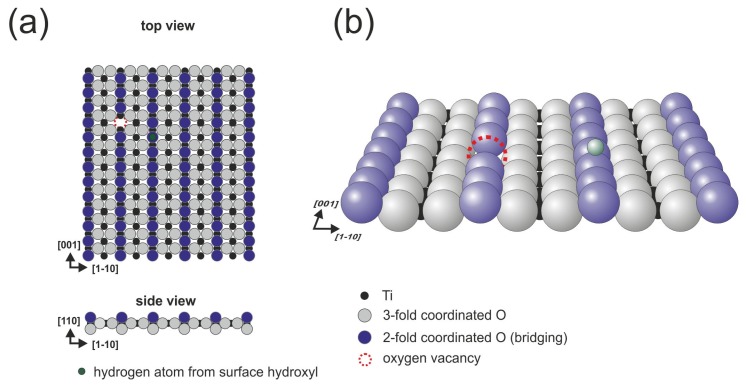
Rutile TiO2(110)-(1 × 1) surface: (a) top view, and (b) perspective view.